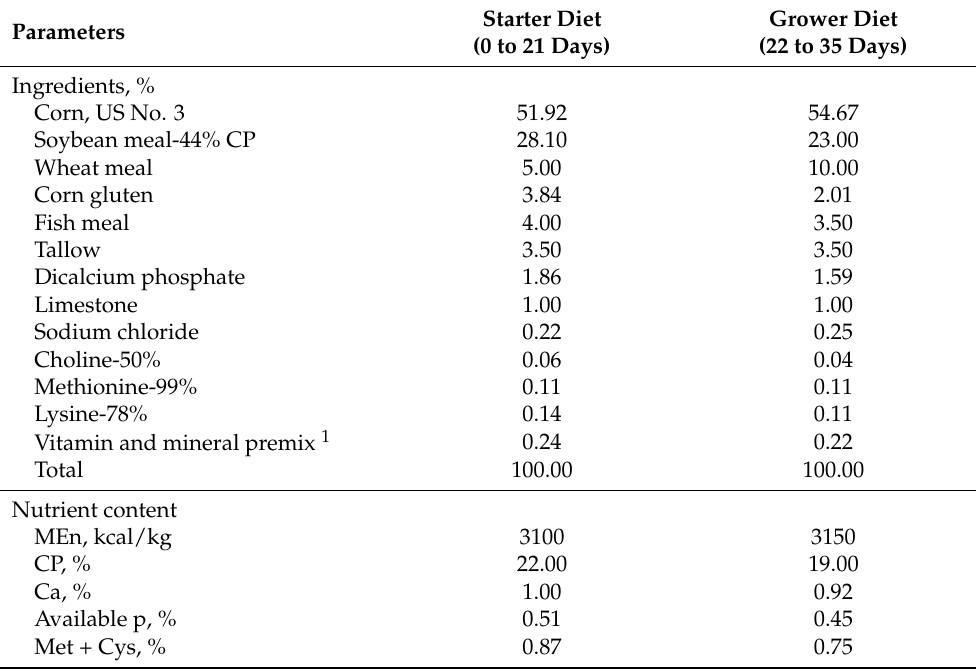
Table 1. Composition and nutrient content of experimental diets (as-fed